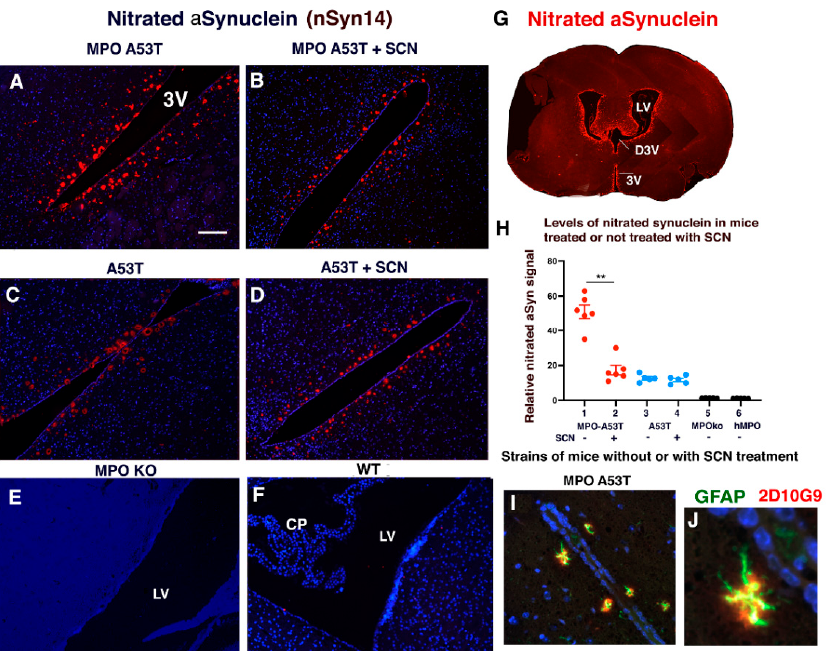
Figure 4. Thiocyanate treatment of hMPO-A53T mice reduces levels of nitrated aSyn in glymphatic vessels surrounding the ventricles. Immunostaining with antibodies to nitrated α Syn (nSyn14) was performed on brain sections from hMPO-A53T and A53T mice that had been treated ( B , D ) or not treated ( A , C ) with SCN − . Higher levels of nSyn14 staining were detected in vessels in hMPO- A53T brain lacking SCN − treatment ( A ) than hMPO-A53T mice treated with SCN − ( B ). A53T brain lacking hMPO ( C ) had less nSyn14 reactivity than hMPO-A53T brain ( A ). There was no difference in levels of nSyn14 reactivity in A53T brain with SCN − treatment ( D ) or without SCN − treatment ( C ). As controls, there were no significant 2D10G9 staining in brains of hMPO KO (C57Bl/6) ( E ) or WT mice ( F ). Scale bar 0.1 mm. ( G ). Coronal section of hMPOA53T brain immunostained for nitrated aSyn in vessels surrounding the lateral ventricles (LV), dorsal third ventricle (D3V) and third ventricle (3V). ( H ) Levels of nitrated α Syn detected by nSyn14 antibody and Alexafluor594, red in areas around the third ventricle. Numbers of mouse brains examined were 5 to 7 for each genotype and treatment. Lane 1 shows hMPO A53T mice not treated with SCN − . Lane 2 shows hMPO-A53T mice that had SCN − treatment. Lane 3 shows A53T mice that lacked SCN − treatment. Lane 4 shows A53T mice that had SCN − treatment. Control lane 5 shows MPO KO (C57Bl/6) mice that lacked SCN − treatment. Lane 6 shows hMPO mice that lacked SCN − treatment. Statistical analysis was conducted in Panel H using GraphPad Prism software (v9) and Student’s t -test for comparing the means of two samples ( p < 0.01 **). ( I ) hMPO-A53T brain was immunostained for GFAP astrocyte marker (green) and 2D10G9 HOCl oxidized epitopes(red) alongside the 3rd ventricle. One vessel is enlarged in ( J ) showing astrocytic processes indicative of